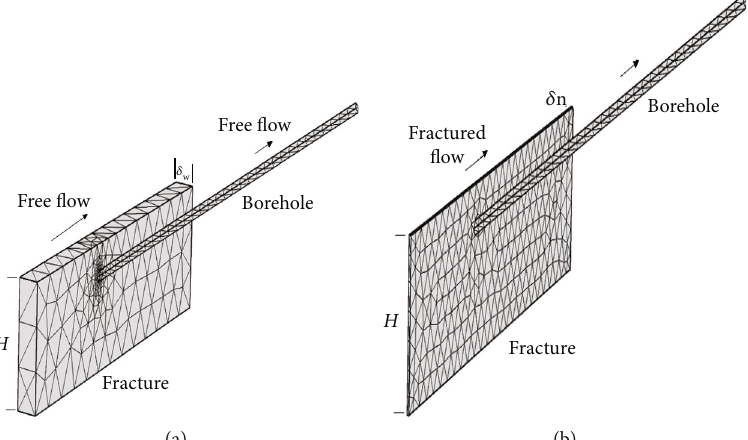
Figure 3: Borehole-fracture fl ow models with (a) large aperture δ by drilling borehole. H is aquifer